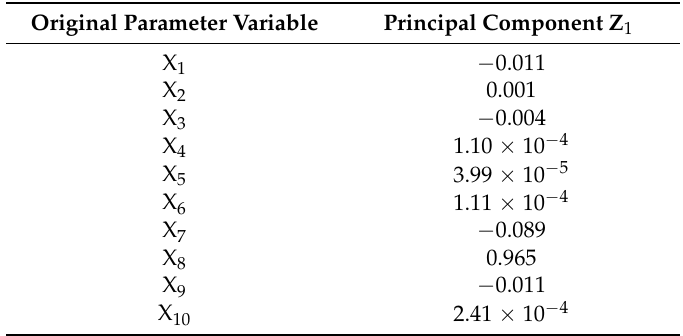
Table 2. Score of Component Coefficient Matrix.